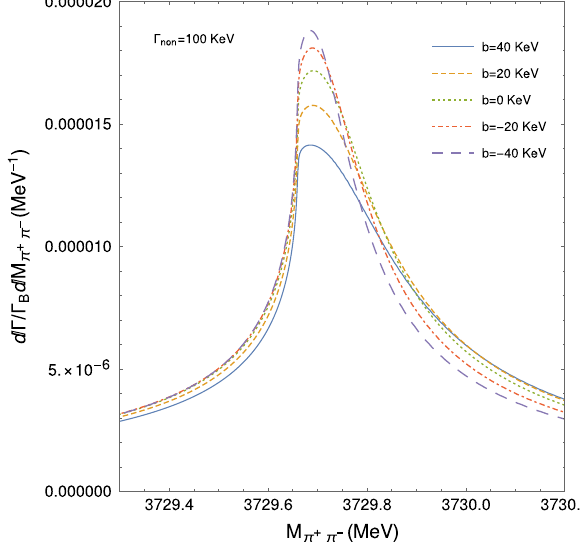
Fig. 10 d (cid:9)/((cid:9) B − dM π + π − ) for (cid:9) non = 100 KeV and different values of b = m D 0 + m D ∗ 0 − m